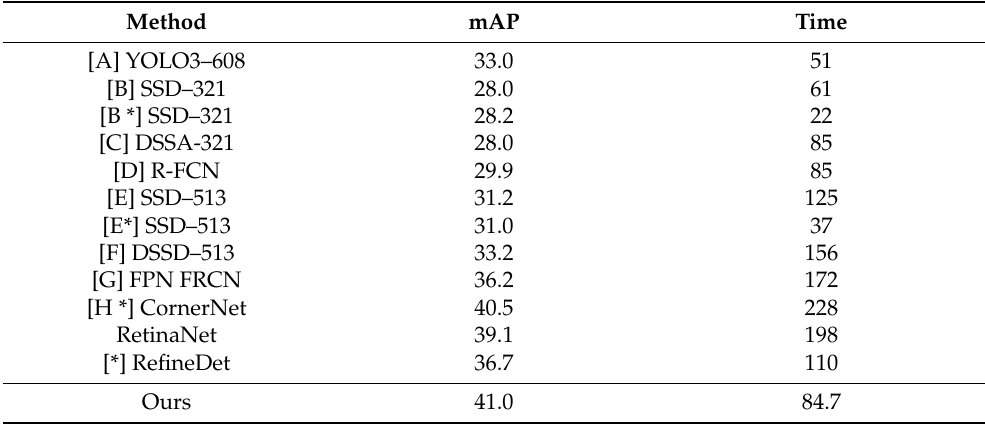
Table 2. Speed-accuracy curve compared with other